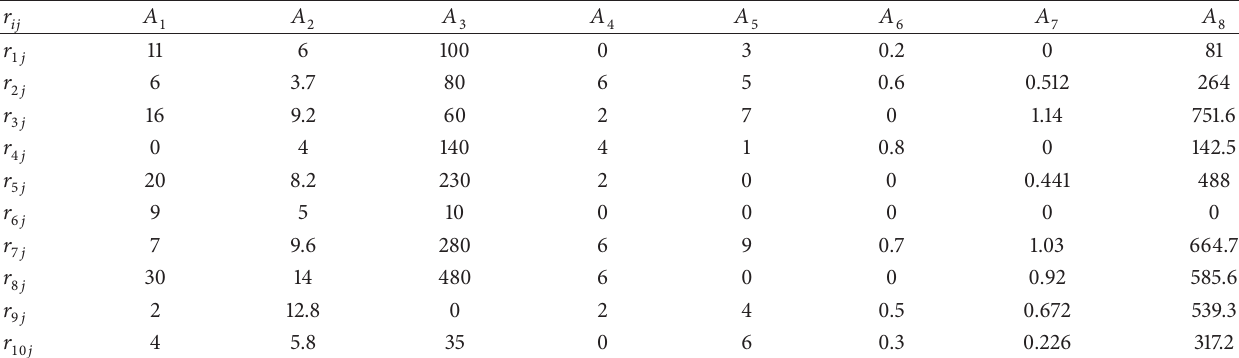
Table 3: All index target centre distances.